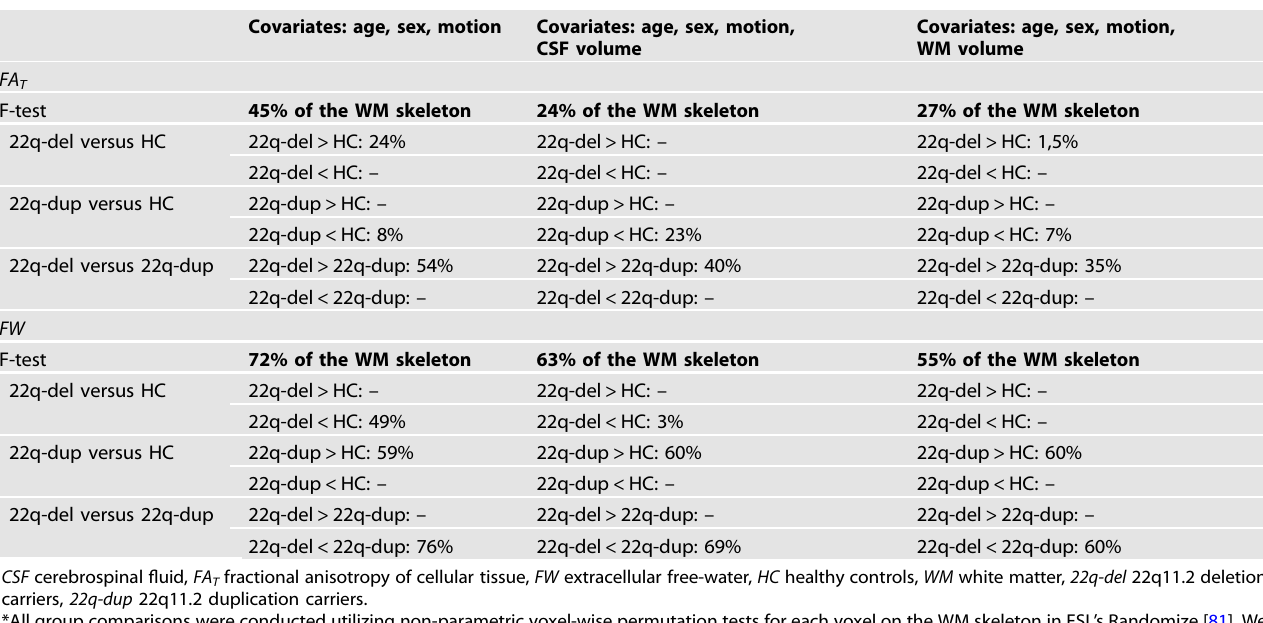
Table 3. FA T and FW group comparisons *.